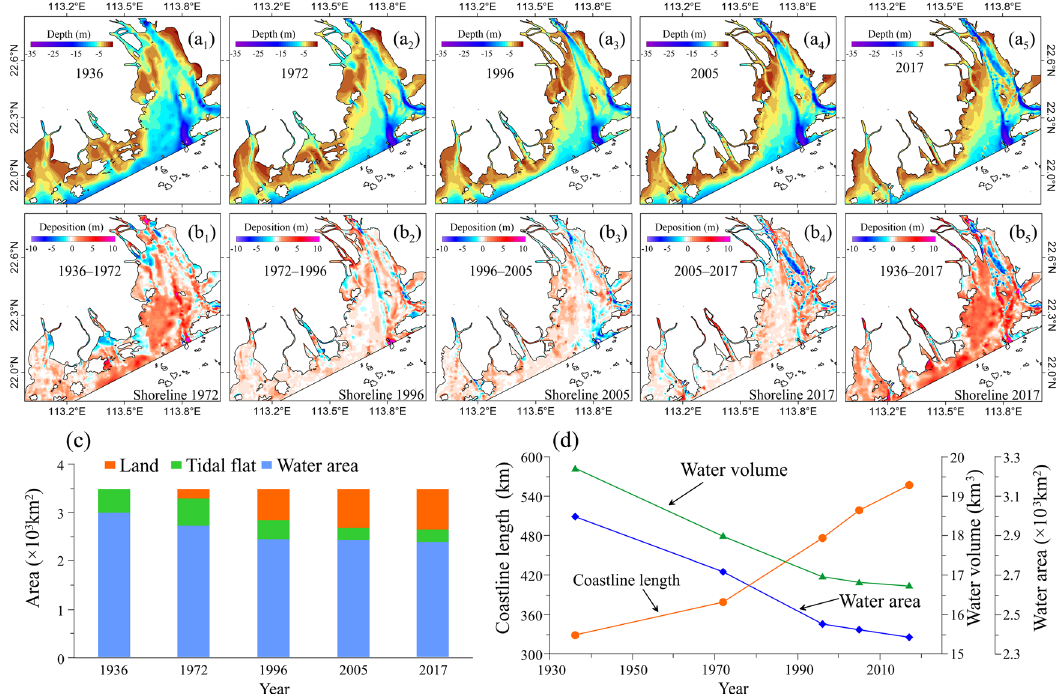
Figure 3. Bathymetric maps of the Pearl River Estuary in 1936, 1972, 1996, 2005, 2017 ( a ) and bathymetric change maps during different periods ( b ). Changes in land area, tidal flat area, and water area for 1936–2017 ( c ). Total length of coastline, water area, and estuary volume for 1936–2017 ( d ). Maps created with Surfer, Version 13, https:// www. golde nsoft ware. com/ produ cts/ surfer, Histograms and line charts were created with Microsoft Office, Version 2016, https:// www. micro soft. com/ zh- cn/.